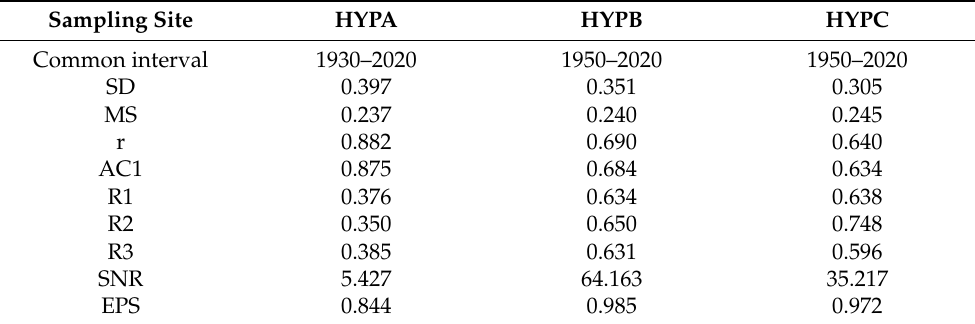
Table 3. Statistical information of the standard L. principis-rupprechtii tree-ring chronologies at different elevations on Guancen Mountain.